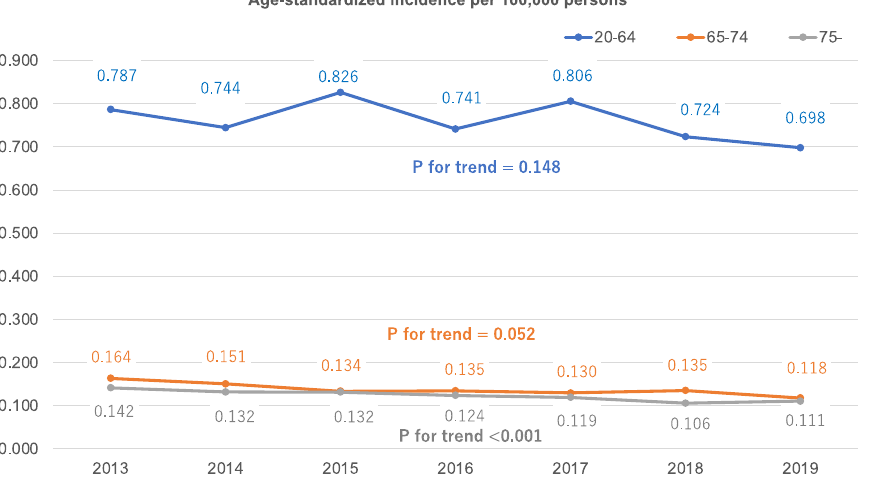
Figure 2. Age-standardized incidences of traumatic out-of-hospital cardiac arrests following traffic collisions.